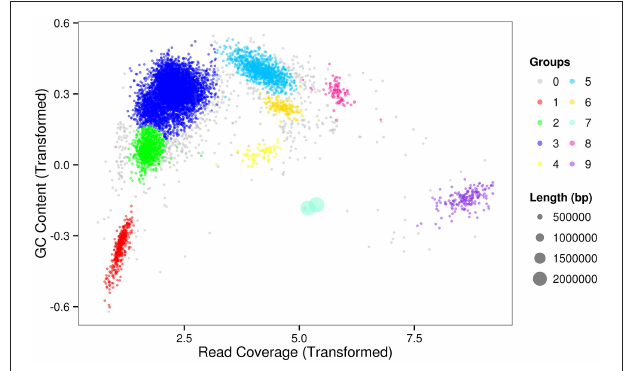
FIGURE 2 | Scatterplot of the final binning results for the metagenomics sample based on the Gaussian mixture model. The points in the figure represent scaffolds assembled from the microbial community and the point size indicates the length of scaffolds. The colored clusters on the graph are potential genomes of each group. The gray points dispersed around the clusters are scaffolds that were difficult for the model to